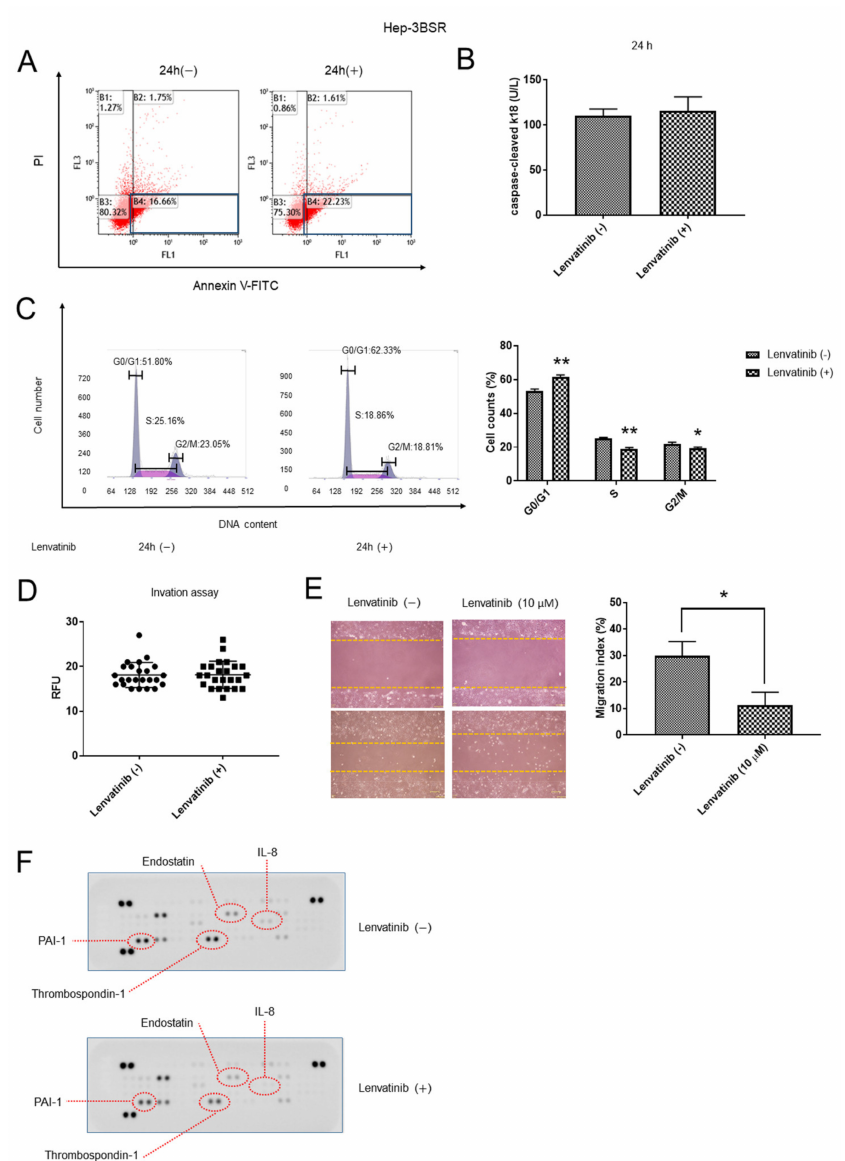
Figure 3. In Hep-3BSR cells, lenvatinib triggers cell cycle G1 phase arrest, reduces migration, and modulates the expression of proteins associated with angiogenesis. ( A ) Hep-3BSR cells were treated with 10 µ M lenvatinib or dimethyl sulfoxide (DMSO) for 24 h, and the level of apoptosis was measured by staining with annexin V and propidium iodide (PI) using flow cytometry. Lenvatinib treatment did not significantly change the average proportion of early apoptotic cells in the Hep-3BSR population. Lower right square represents early apoptosis. ( B ) The expression of caspase-cleaved cytokeratin 18 (cCK-18) was determined using Enzyme Linked Immunosorbent Assay (ELISA). After 24 h of treatment with 10 µ M lenvatinib, cCK-18 levels remained changed. ( C ) Hep-3BSR cells treated with 10 µ M lenvatinib or DMSO were analyzed using flow cytometry to determine the number of cells in each phase of the cell cycle (left panel). Representative cell cycle histograms are presented (right panel). Lenvatinib blocked the cell cycle at the G0/G1 phase. ( D ) Invasion ability of lenvatinib-treated Hep-3BSR cells was not significantly changed. ( E ) Wound-healing assay comparing the motility of Huh-7SR cells treated with lenvatinib or DMSO. The wound-healing area was analyzed using ImageJ software. ( F ) Representative expression of angiogenesis-related proteins, endostatin, thrombospondin-1 (TSP-1), interleukin-8 (IL-8), and PAI-1, in Hep-3BSR cells incubated with lenvatinib or DMSO for 24 h. Data are presented from three independent experiments. * p < 0.05, ** p <